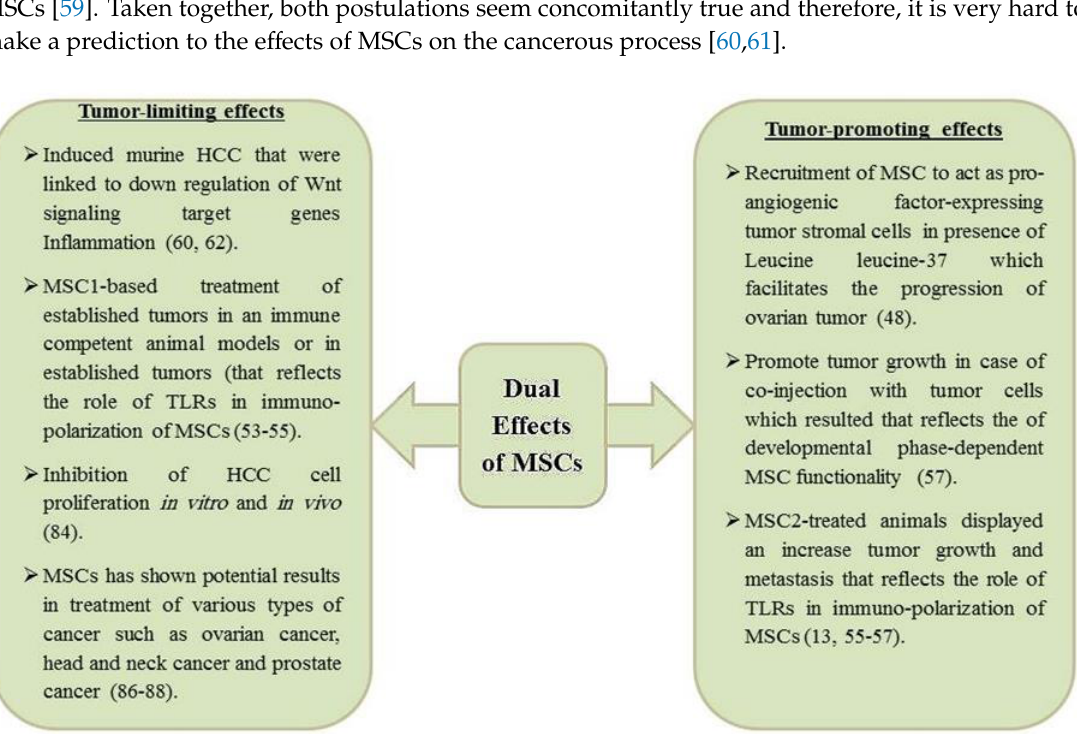
Figure 1. The pleiotropic functionality of mesenchymal stem cells (MSCs) which tumor-limiting and tumor-promoting effects.